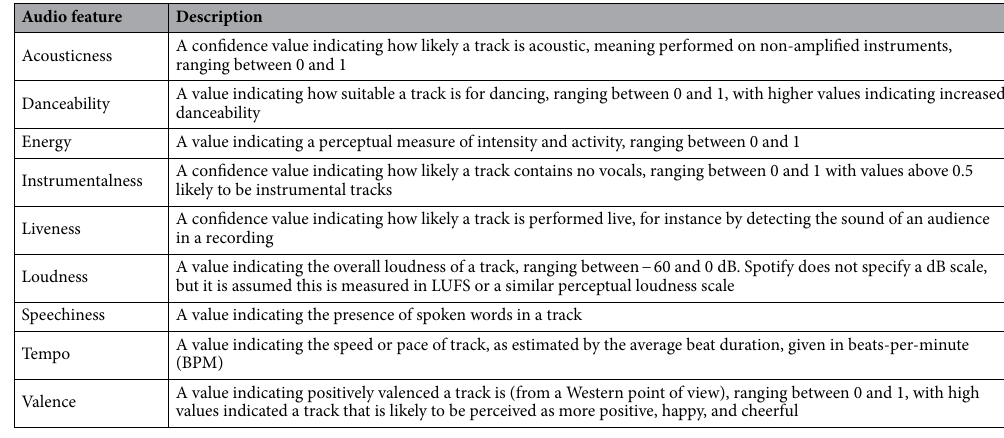
Table 1. Overview of the audio features that are accessible through the Spotify API and their descriptions as given by Spotify 50 .